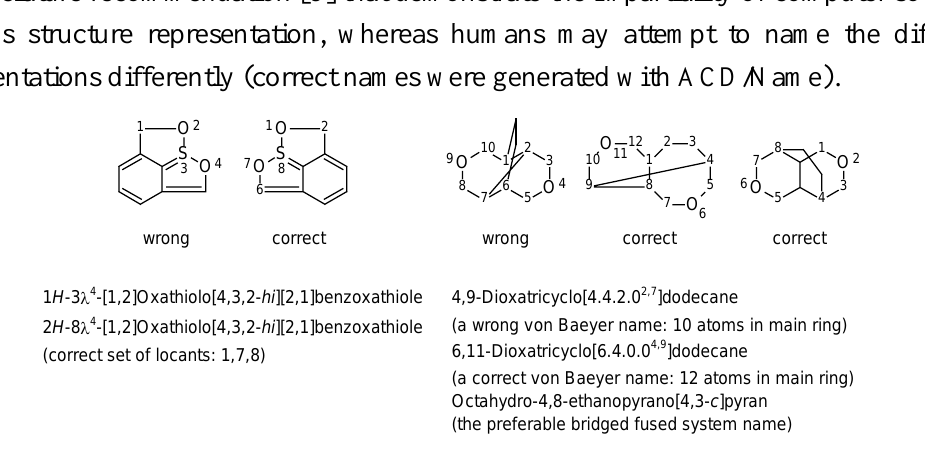
Figure 5. Originally incorrectly named examples extracted from a